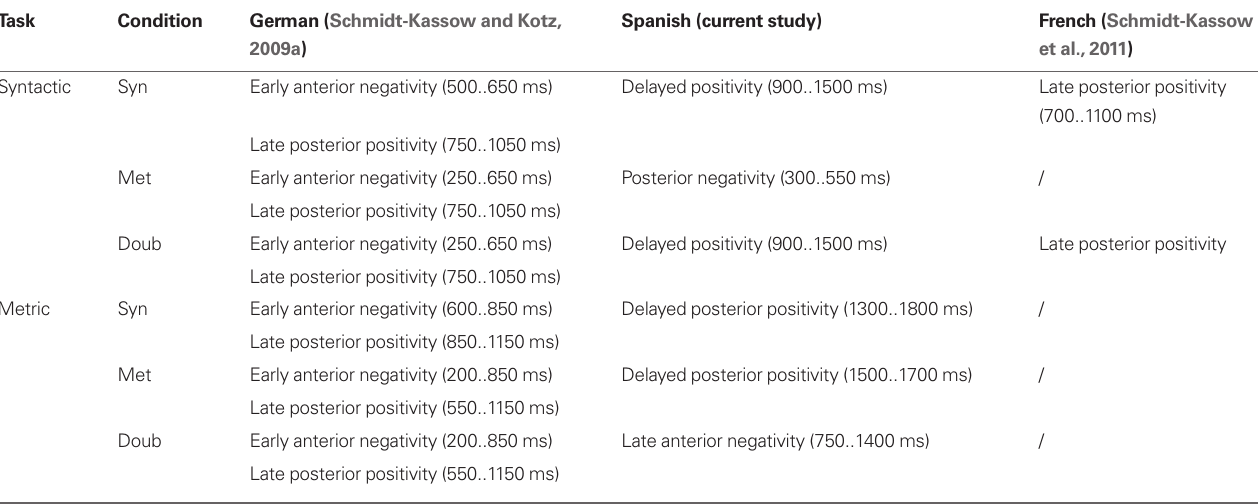
Table 2 | Comparison of erP data from previous studies with recent